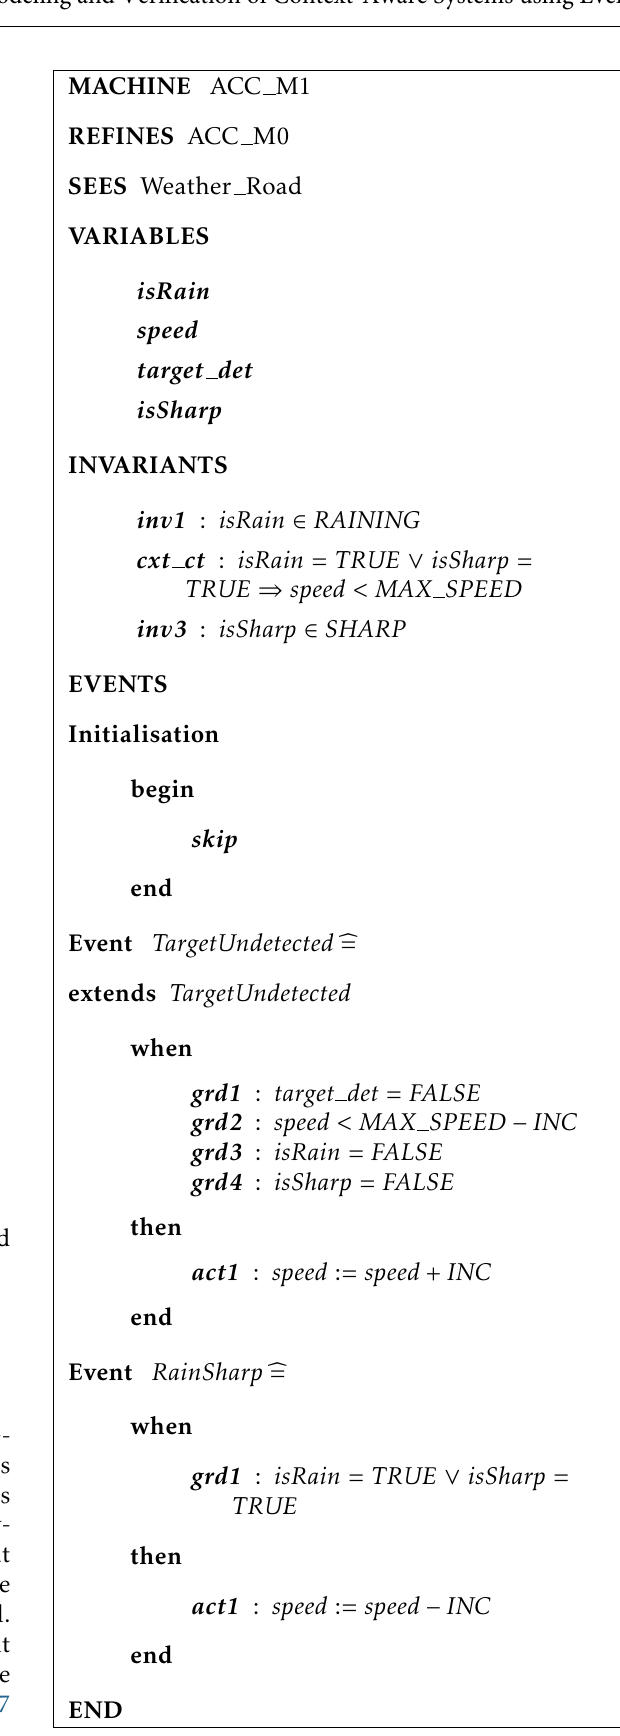
Figure 7. Refined machine for ACC